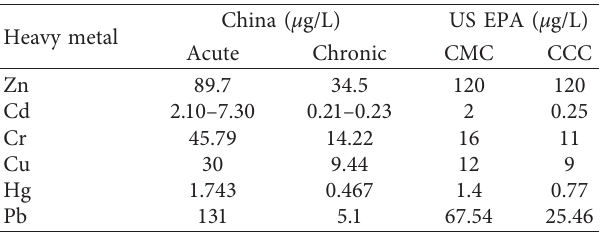
Table 2: Comparison of water quality criteria of heavy metals in China and the US EPA [12,